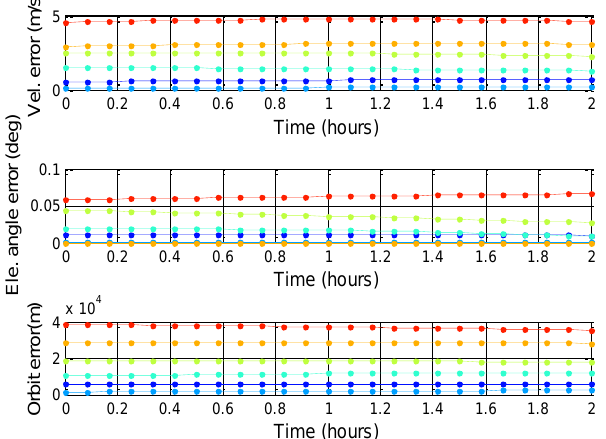
Figure 24. BDS MEO almanac using period test for five